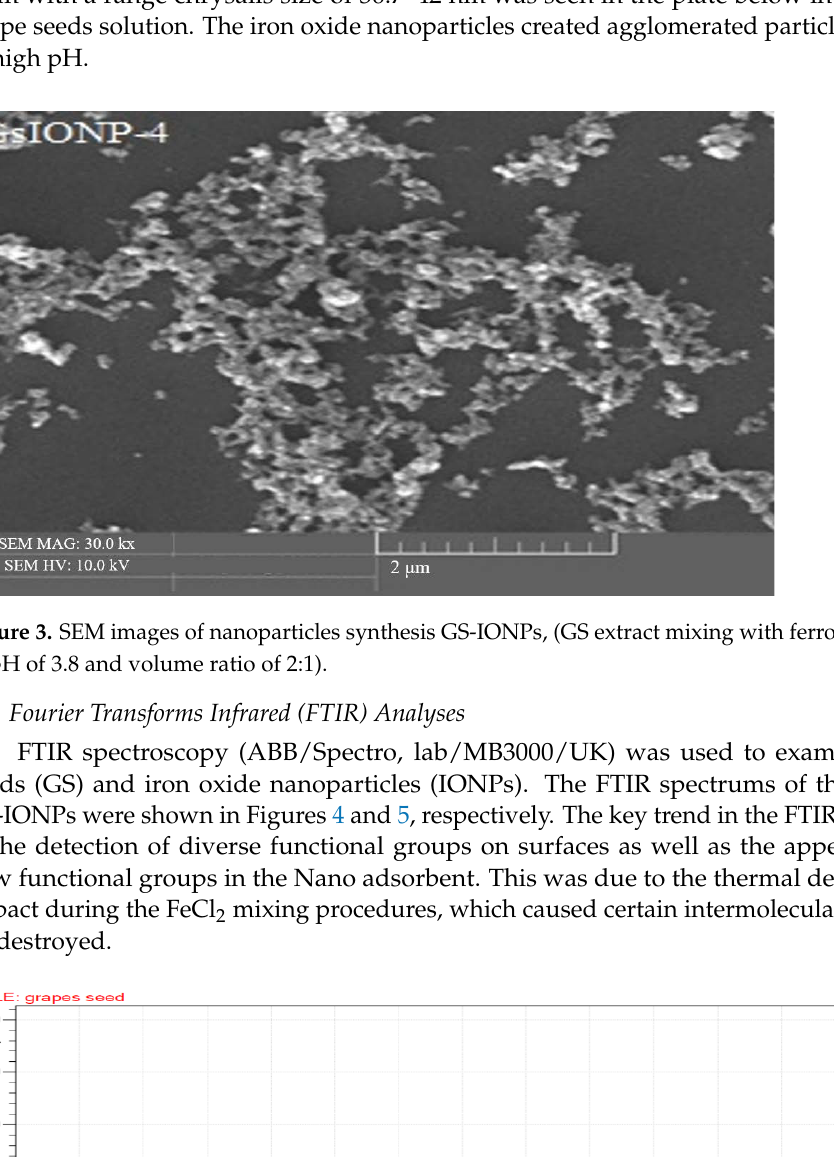
Figure 5. FTIR spectrum of iron oxide nanoparticles synthesis by grape seed extract under (GS water extract mixing with ferrous chloride (GS-IONPs) at pH 3.8 and ratio 2:1). Consequently, the rotational vibrations due to distinct IR absorption according to wavelength (cm − 1 ) were allocated for vibrations appearing between 4000 and 2500, 2500 and 200, and 200 and 1500 cm − 1 , according to the examination of the FTIR spectrum images for the present manufactured GS-IONPs displayed in Figure 5. The findings demonstrated that the grape seed water extract-prepared iron oxide nanoparticles contained compo- nents rich in O-H, C-C, N-H, and COOH at an IR absorption range of 3400–1500 cm − 1 , as well as an absorption in the fingerprint area of 750–529 cm − 1 , which was specific for iron oxide limits.